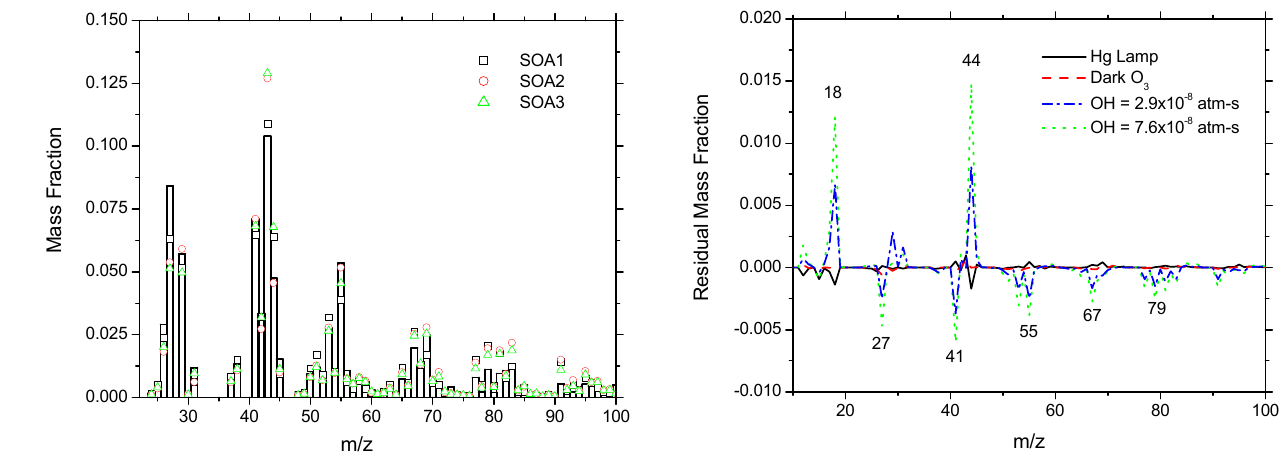
Fig. 1. Mass spectra of SOA1, SOA2, SOA3 in symbols and cham- ber SOA in bars (Bahreini et al., 2005) Mass spectra are normalized to unity.